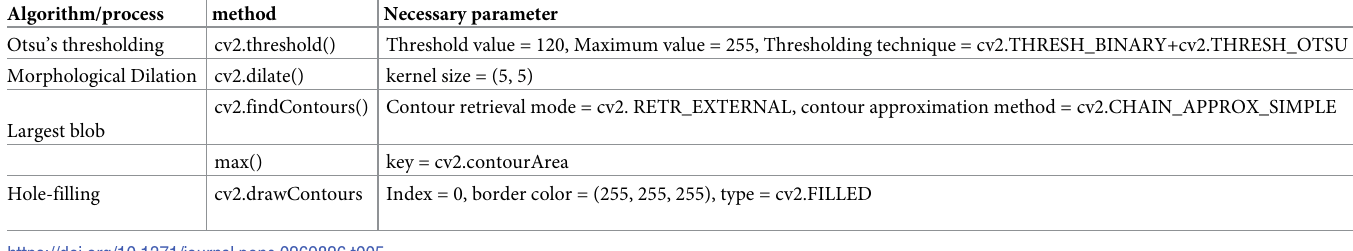
Table 5. Selected parameter value for segmentation process.